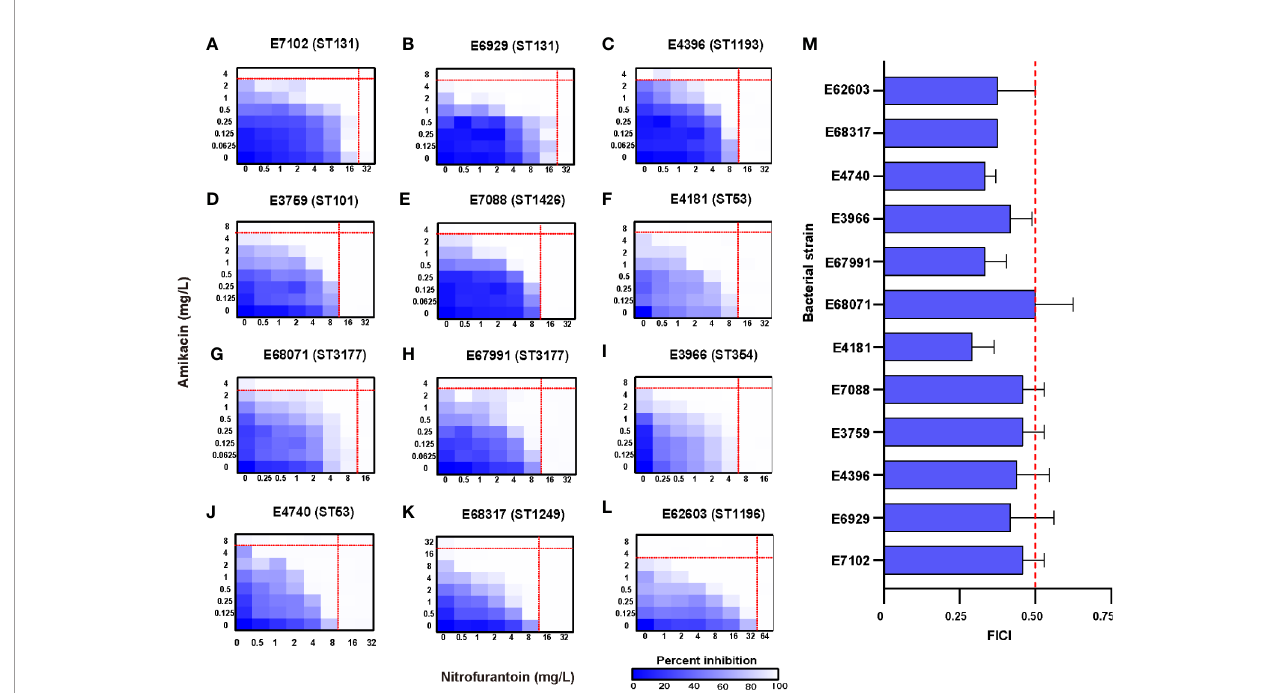
FIGURE 1 | Potentiation of amikacin partnered with nitrofurantoin against 12 test strains. (A – L) Microdilution chequerboard assays are shown as 8×8 matrix heat map graphs. The blue colour gradient represents the bacterial cell density estimated by OD 600 . AMK, amikacin; NIF, nitrofurantoin. (M) FICI of the test strains where synergy is de fi ned as a FIC index of ≤ 0.5. The thin red line represents the (MICs) for antibiotics used separately and the think one represents the FIC index of